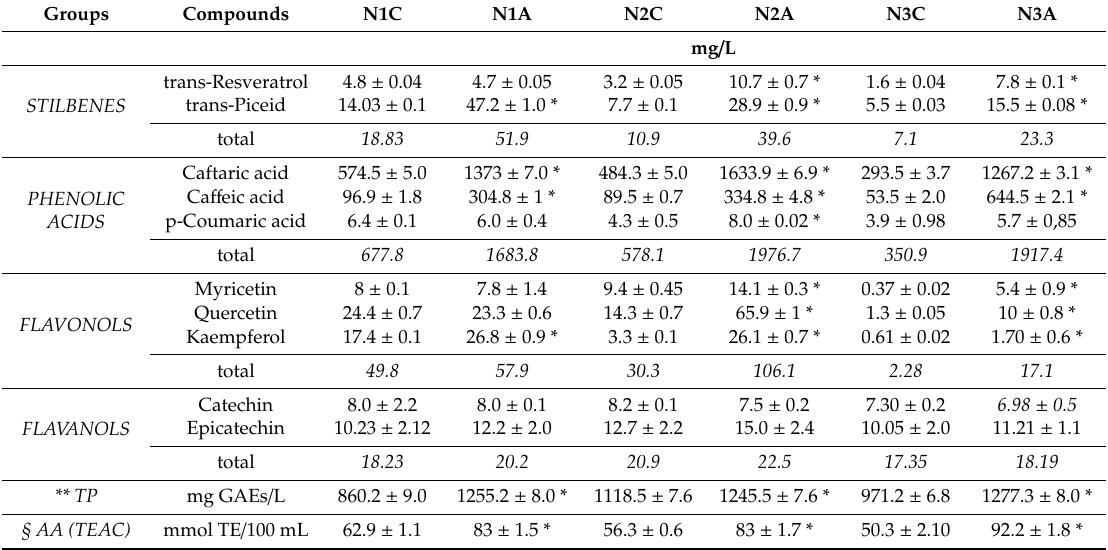
Table 3. Comparison of di ff erent classes of polyphenols content in Negroamaro wine extracts fermented with commercial yeast (NC) and Negroamaro wine extracts obtained by utilizing selected autochthonous yeast strain (NA). Comparison of Total Phenols content (TP) and Antioxidant Activity (AA) in Negroamaro wine extracts (NC and NA). Results reported in table are expressed as the mean ± SD of three